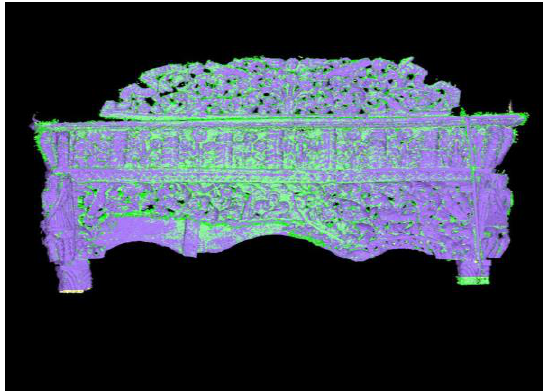
Fig. 6b Mesh-to-mesh comparison between the SfM and laser surfaces